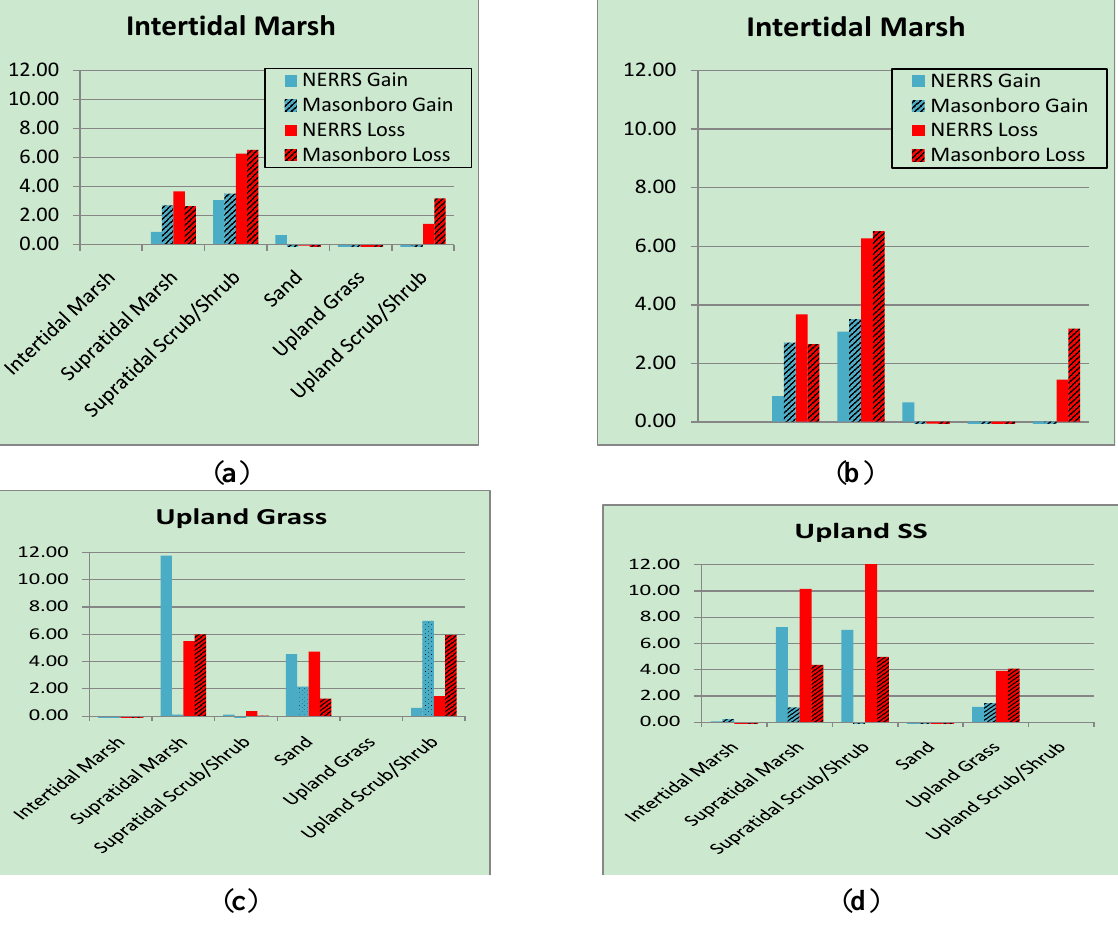
Figure 12. The ratio of deviation to expected change for gain (blue) and loss (red) for selected habitat classes. The class in the title gained and lost more than expected over the classes along the